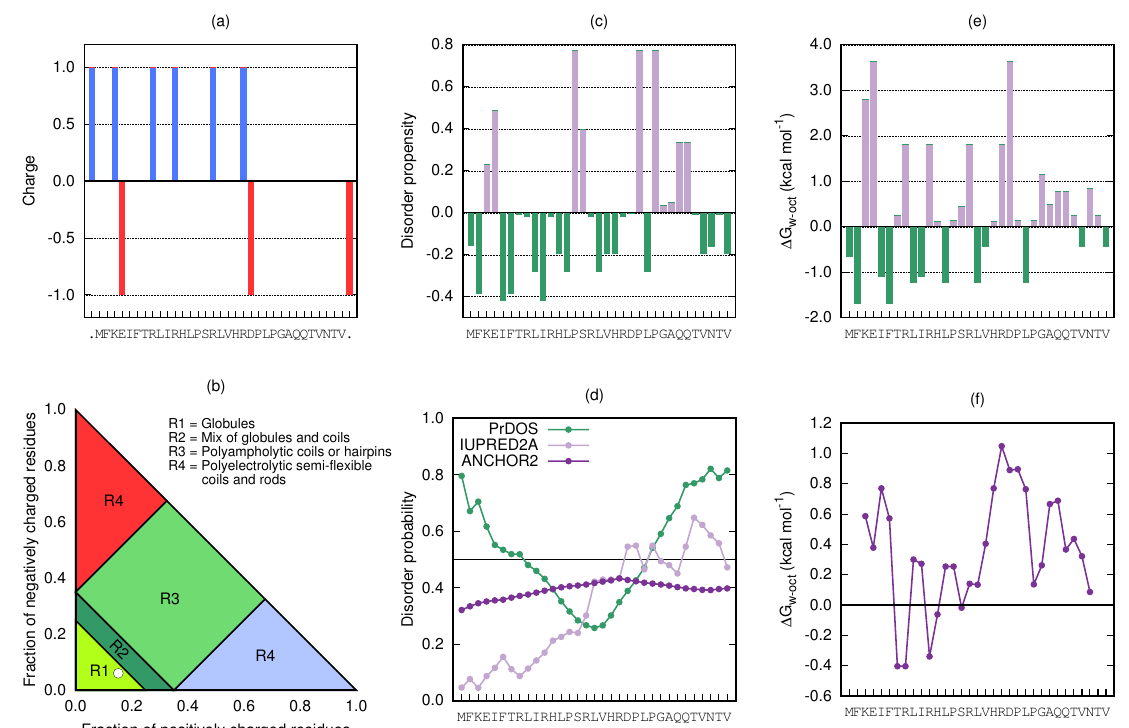
Figure 2. Primary structure analyses of KEIF: ( a ) Estimated charge per amino acid residue. Charge of peptide termini included as separate residues and marked as dots in the x-axis label. ( b ) Das–Pappu plot [33,34]. KEIF location is indicated by white circle in Region R1. ( c ) Disorder propensity per amino acid ( C DisProt − C PDB ) / C PDB , as described by Uversky (2013) [35]. ( d ) Probability prediction of disordered regions and disordered binding regions using PrDOS (green) [36], IUPred2A (light purple), and ANCHOR2 (dark purple) algorithms [37]. ( e ) Whole-residue Wimley–White hydrophobicity indices [14,15] per amino acid residue. ( f ) Kyte–Doolittle [38] smoothed (five amino acid sliding-window) hydropathy plot based on whole-residue Wimley–White